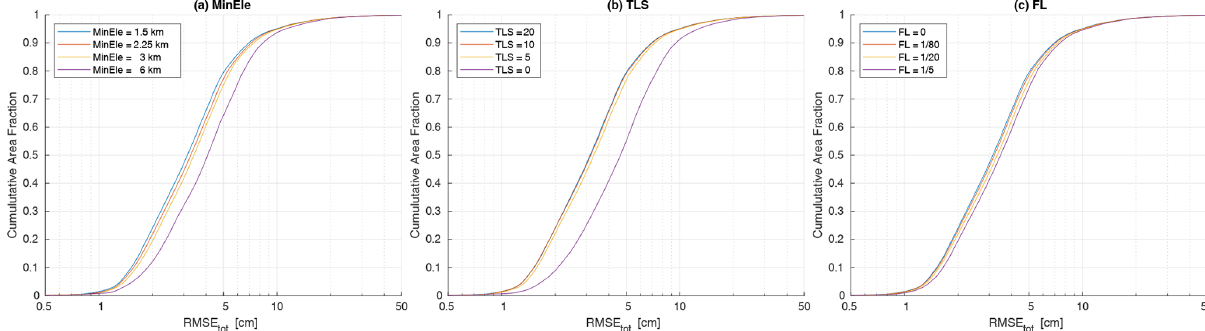
Figure 7. Area-weighted ECDF curves of RMSE t | tot for the global mesh designs varying MinEle (a) , TLS (b) , and FL (c) . See Table 2 for mesh design details.